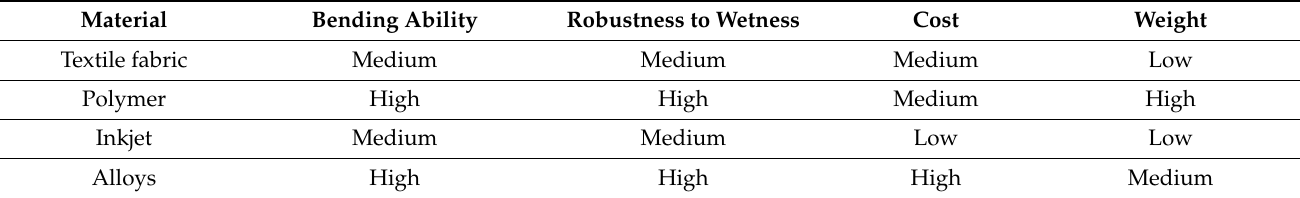
Table 2. Antenna Materials